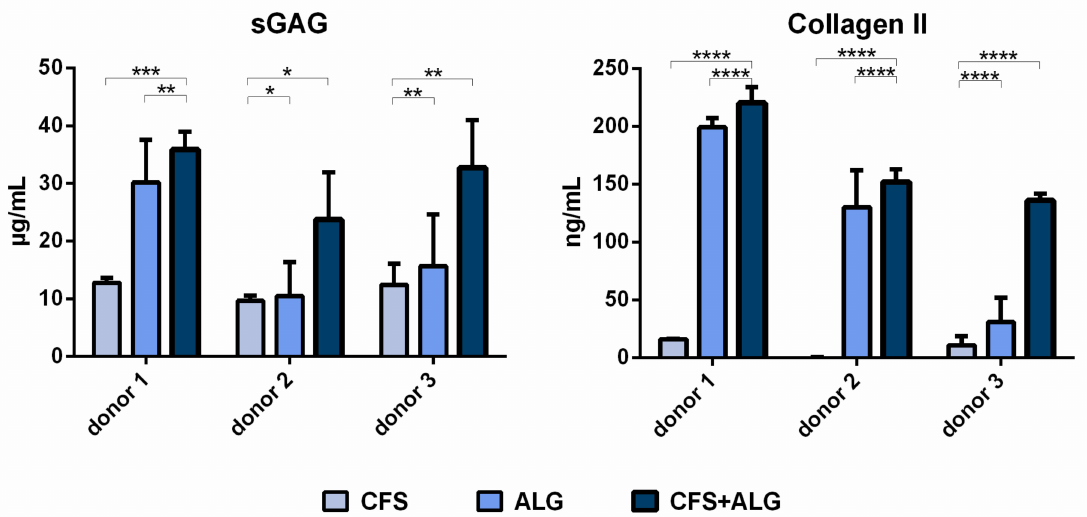
Figure 8. sGAG concentration in cell culture medium and collagen II in scaffolds, seeded with human chondrocytes of 3 donors 21 days after seeding in chitosan flock scaffolds (CFS), alginate hydrogels (ALG) and chitosan/alginate flock scaffolds (CFS+ALG). sGAG was determined using an assay based on Alcian blue, and collagen II was detected on protein level using ELISA. The results are shown as mean ± SD, n = 3. p -value **** < 0.0001, *** 0.0001–0.001, ** 0.001–0.01, *